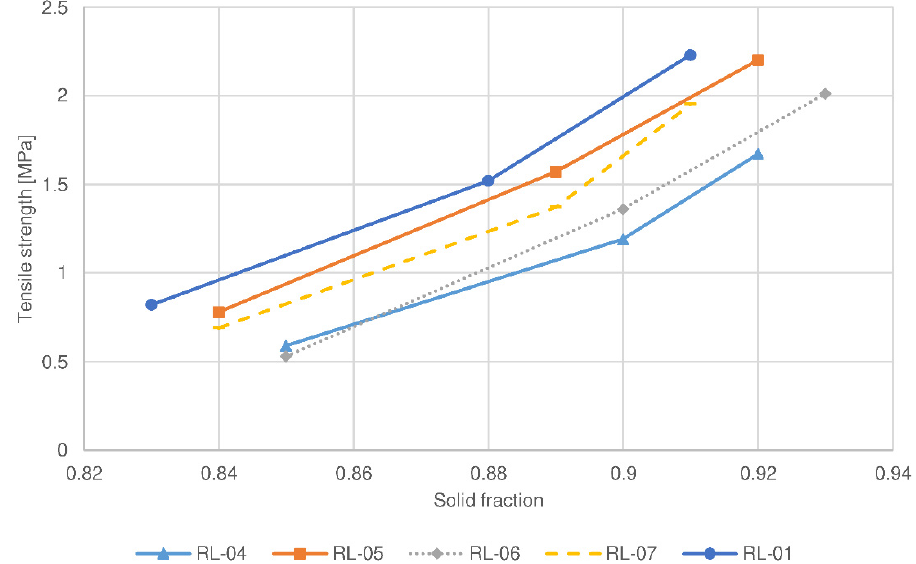
Figure 4. Compactibility plot of selected compression mixtures containing lactose as a filler. Table 3. Results of particle size distribution (d50 and d90 values obtained by SFT*), granule friability calculated from d [4, 3] and d90 values of laser diffraction, granule porosity, and granule shape (sphericity and aspect ratio) of selected